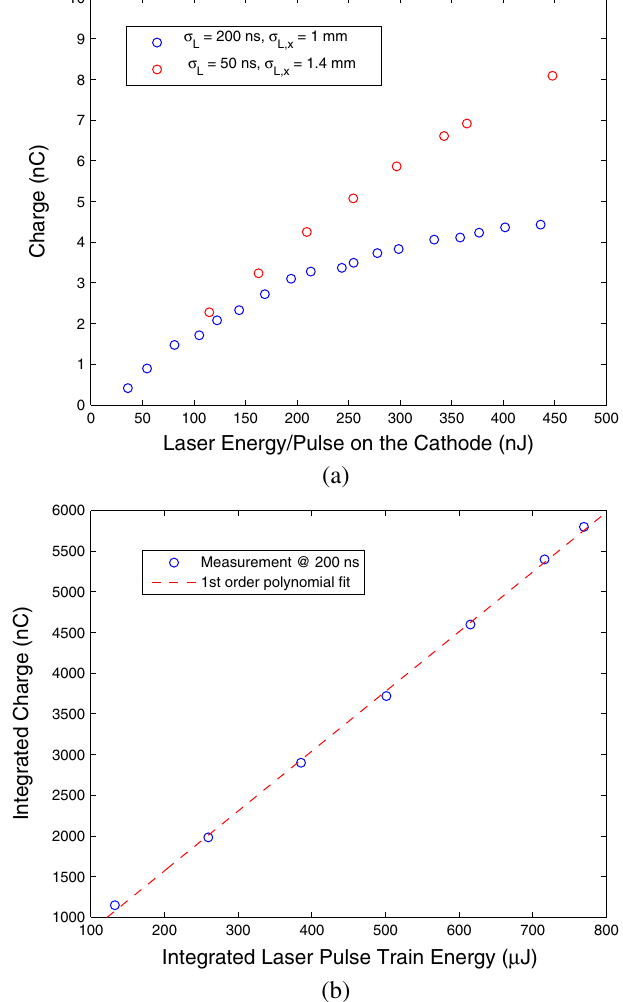
FIG. 4. (a) Photoinjector charge yield per bunch with the increasing laser pulse energy for different laser spot sizes and train lengths denoted by (cid:2) L;x and (cid:2) L , respectively. (b) The linear behavior of the photoinjector in terms of the integrated charge and the laser energy over the pulse